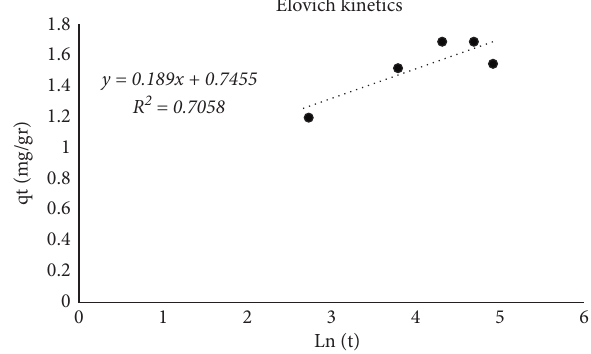
Figure 13: Zero-order kinetics for MG